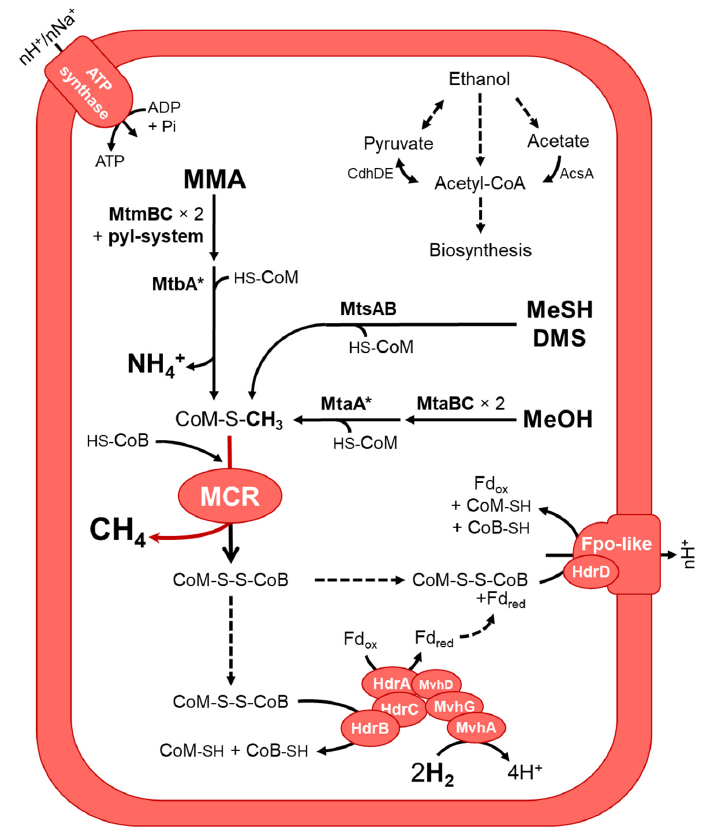
Figure 5. Predicted metabolic pathways for methanogenesis, carbon assimilation, and energy conservation in Ca. ‘Methanomassiliicoccus armoricus MXMAG1’, belonging to the ‘free-living clade’ of Methanomassiliicoccales . Genes encoding the MtmBC and MtaBC enzymes were found in two copies in the MAG. The “*” symbol indicates the presence of enzyme homologous to the MtaA/MtbA which are found in other Methanomassiliicoccales for MeOH and MMA incorporation, as described elsewhere [22]. Legend: CdhDE, Acetyl-CoA decarbonylase/synthase complex subunits; DMS, dimethylsulfide; MeOH, methanol; MeSH, methanethiol, MMA, monomethylamine.